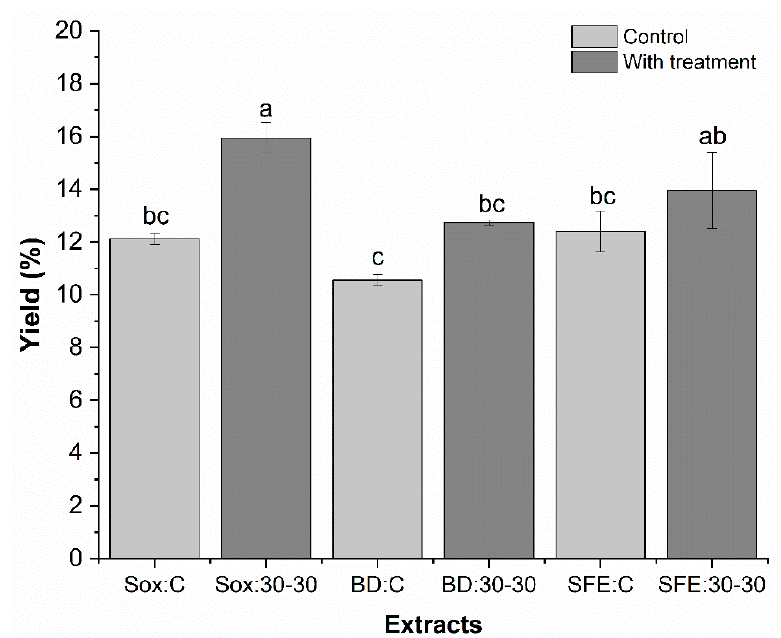
Figure 3. Determination of yield (%) of grape seed oils obtained by low pressure (Sox and BD) and supercritical extraction (SFE) methods. The bars in each column represent the standard error. Samples with the same letter showed no significant difference (p > 0.05) by the Tukey test with 95% confidence.